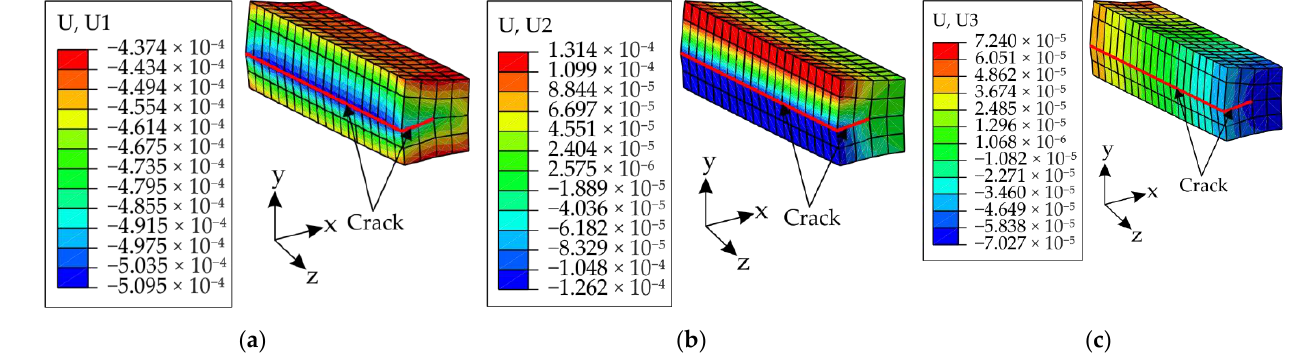
Figure 8. The wrongly mapped displacements on the submodel along the principal axes: ( a ) Along x-axis; ( b ) Along y-axis; ( c ) Along z-axis. x-axis; ( b ) Along y-axis; ( c ) Along